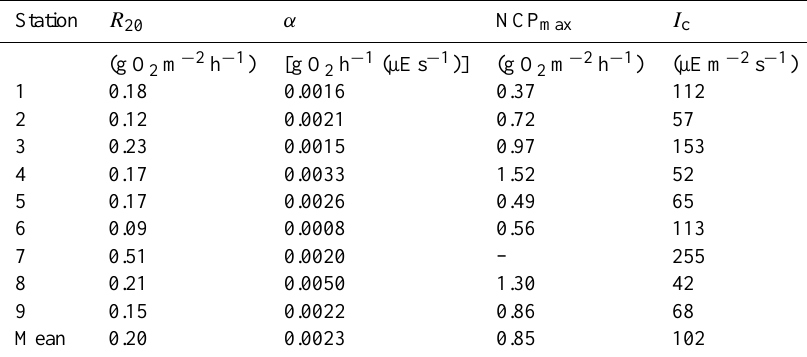
Table 3. The photosynthetic parameters: dark respiration rate ( R 20 ), initial slope ( α ), maximum net community production (NCP max ) and light compensation point ( I c ) of the entire community (benthic and pelagic) in nine shallow Do˜nana lagoons, based on 24h. measurements. All measurements normalised to 20 ◦